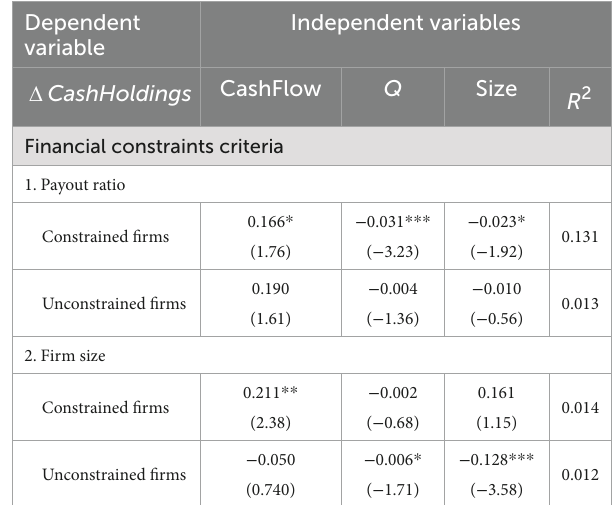
TABLE 7 Proof of the existence of financing constraints benchmark regression results.